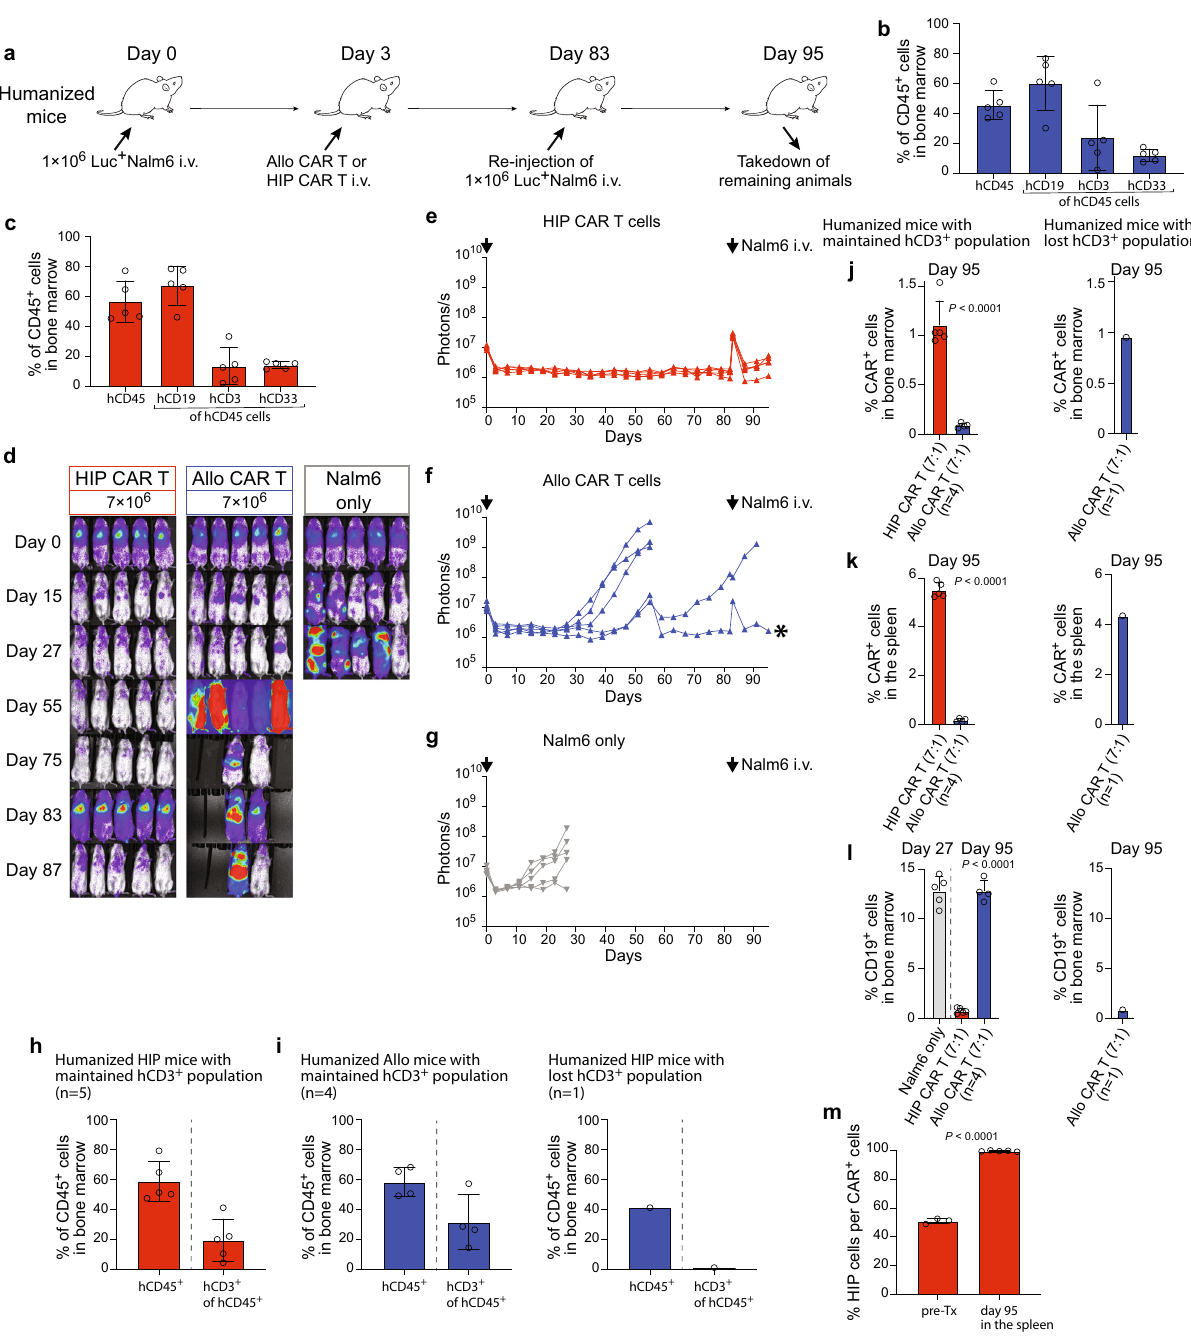
spleen ( k ) were assessed separately for animals that had maintained their hCD3 + population ( n =5 in the HIP CAR T group and n =4 in the allo CAR T group, mean±SD). The one animal in the allo CAR T group that had lost their hCD3 population is shownseparately. Signi fi cantdifferences between the two CART cell groupsareshown. l ThepercentageofCD19 + cellsinthebonemarrowwasassessed separatelyforanimalsthathadmaintained theirhCD3 + population( n =5in theHIP CAR T group and n =4 in the allo CAR T group, mean±SD). The one animal in the allo CAR T group that had lost their hCD3 population is shown separately. m The percentages of the HIP-edited cells in the HIP CAR T cell product before injection ( n =3) and the percentages of HIP-edited cells among the recovered CAR + cell populationfromthespleenon day95( n =5)areshown(mean±SD, unpaired,two- tailed Student ’ s t test). For ( h – l ): Endpoint values from earlier euthanized mice in thealloCARTgroupduetohightumorburdenwereincludedintheday95graphs to show all values at the individual endpoint. For ( j – l ): Unpaired, two-tailed Stu- dent ’ s t test was used to compare HIP and allo CAR T cell groups and signi fi cant differences are